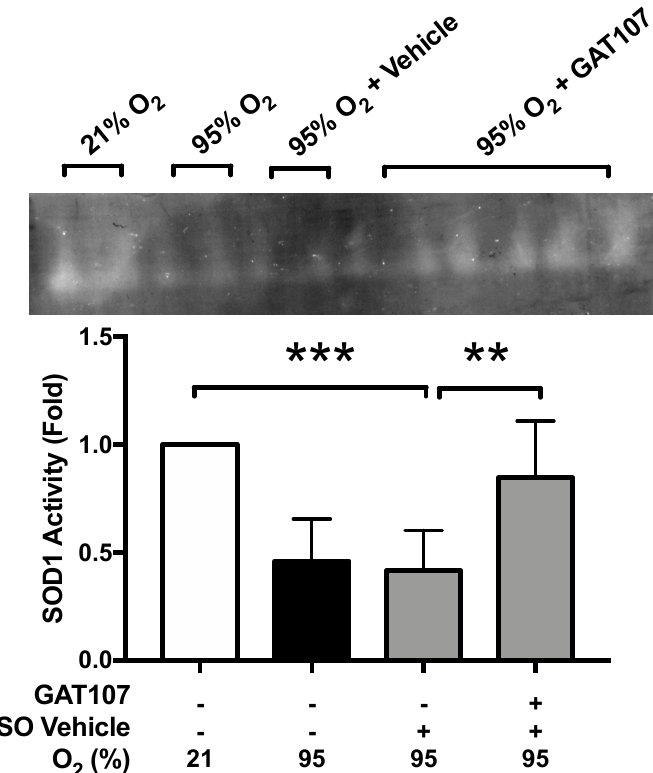
Figure 4. GAT107 restores superoxide dismutase 1 activity in hyperoxia-compromised macrophages. RAW 264.7 cells were either exposed to 21% O 2 (room air) (white bar) or 95% O 2 (hyperoxia) (black bar) in the presence or absence of 3.3 µ M GAT107 (grey bars). After 24 h of exposure to hyperoxia, SOD1 activity was determined using the gel-based nitro tetrazolium blue gel assay, as described in Section 2, and was reported as a fold-change compared to the room air control group. Each value represents the mean ± SEM of three independent experiments for each group. Statistical differences were determined between all groups and indicated as *** p < 0.001 or ** p < 0.01 compared hyperoxia-exposed group treated with vehicle.